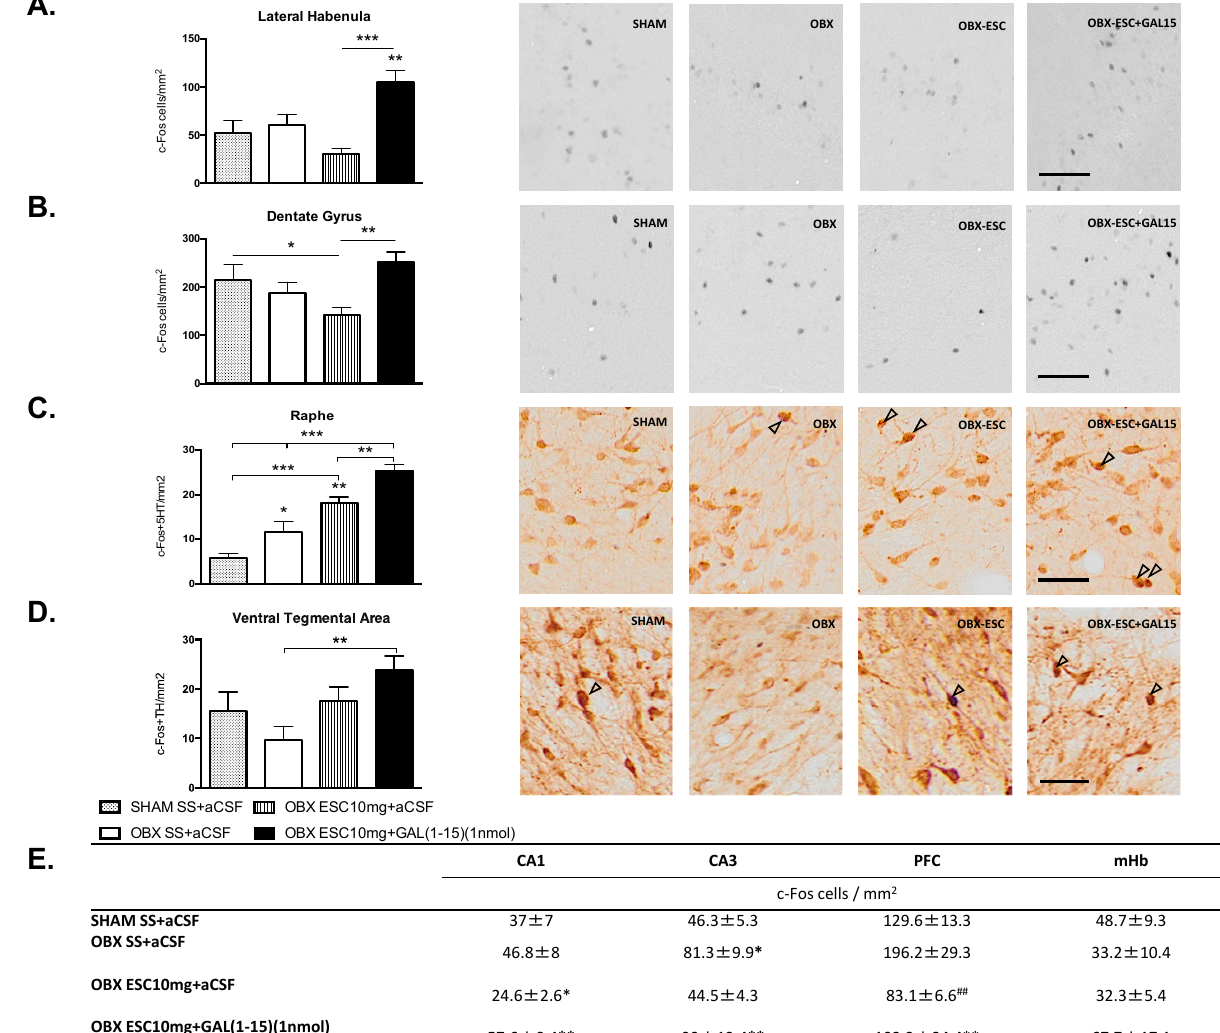
Figure 4. Effects of ESC10 mg and GAL(1-15) (1 nmol) alone or in combination on c-Fos expression. Data represent mean ± SEM of c-Fos cells/mm 2 in dorsal hippocampus (dentate gyrus (DG), CA1, CA3), prefrontal cortex (PFC), lateral habenula (LHb), and medial habenula (mHb). The mean ± SEM of c-Fos/5HT in the dorsal raphe (DR) and c-Fos/TH cells/mm 2 in the ventral tegmental area (VTA) is also shown. One way ANOVA followed by Fisher multiple comparison test (n = 3–5 in each group). In subfigures ( A – D ), a representative photomicrograph illustrating the different treatments are also shown. Scale bar = 100 µ m. In ( A ) ** p < 0.01 versus OBX SS+aCSF and SHAM SS+aCSF and *** p < 0.001 versus OBX ESC10 mg/kg+aCSF. In ( B ) * p < 0.05 SHAM SS+aCSF versus OBX ESC10 mg/kg+aCSF and ** p < 0.01 versus OBX ESC10 mmg/kg+aCSF; In ( C ) * p < 0.05 versus SHAM SS+aCSF and ** p < 0.01 versus OBX SS+aCSF; In ( D ) ** p < 0.01 versus OBX SS+aCSF; In ( E ): In CA1, * p < 0.05 versus OBX SS+aCSF and ** p < 0.01 versus OBX ESC10 mg/kg+aCSF. In CA3, * p < 0.05 versus OBX ESC10 mg/kg+aCSF and SHAM SS+aCSF, and ** p < 0.01 versus OBX ESC10 mg/kg+aCSF and SHAM SS+aCSF. In PFC ** p < 0.01 versus OBX ESC10 mg/kg+aCSF and ## p < 0.01 versus OBX